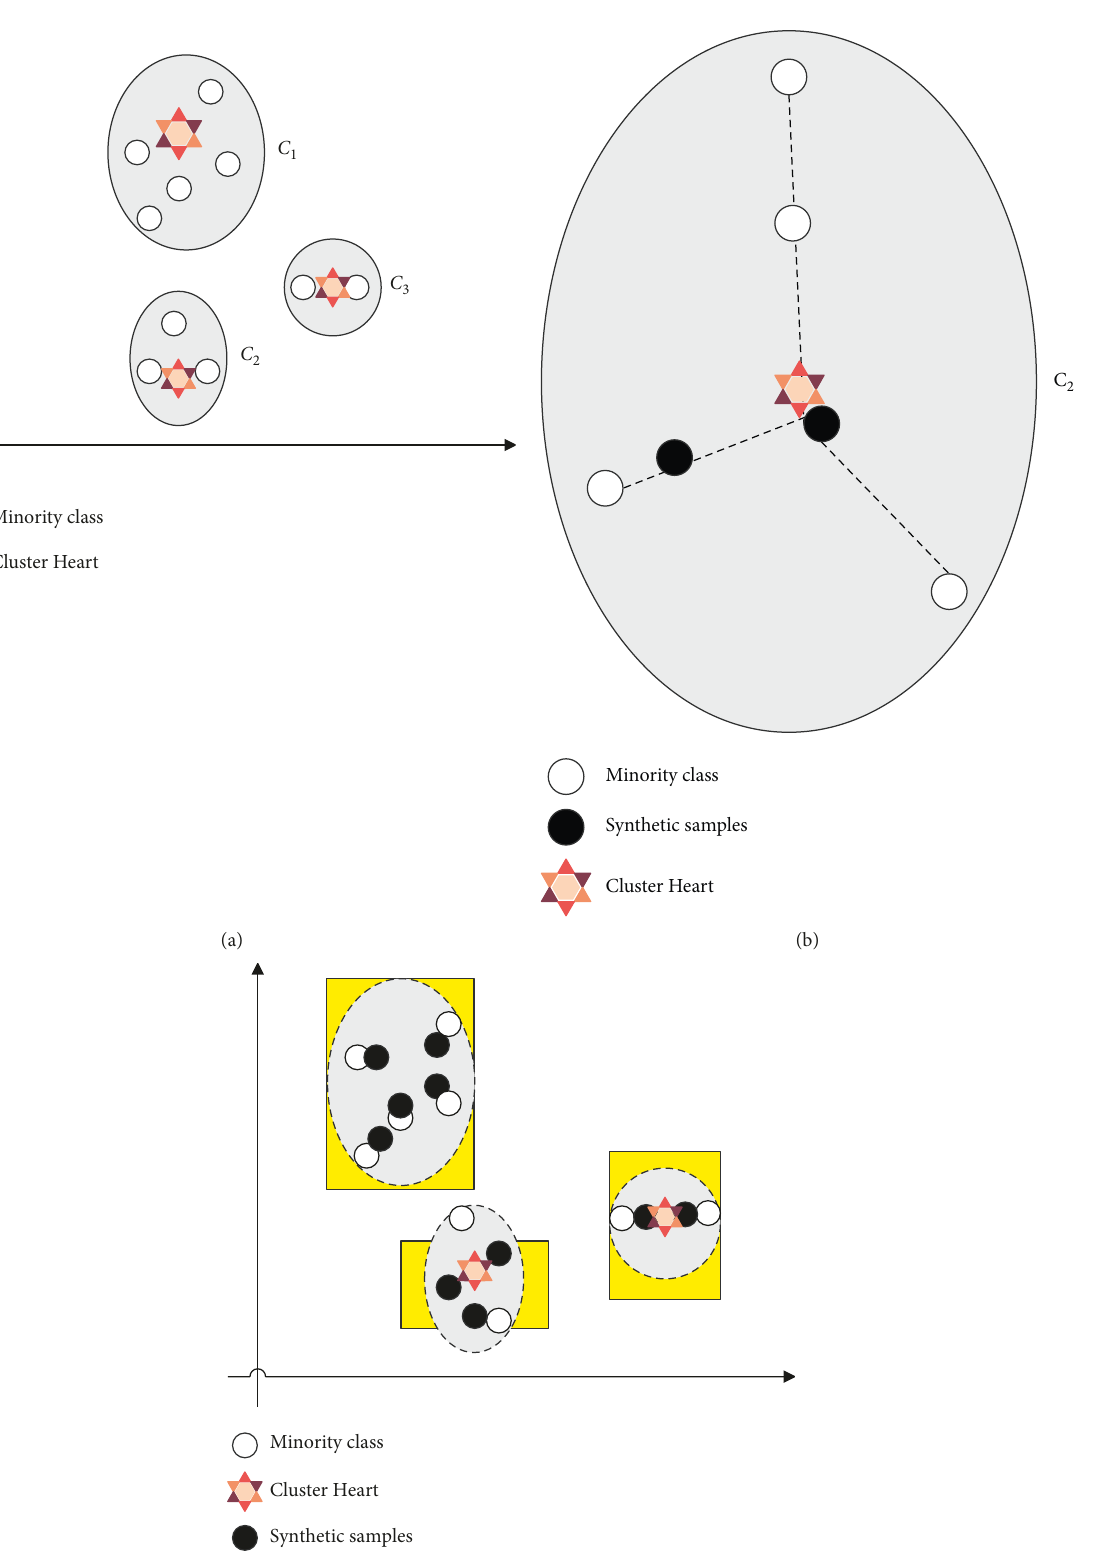
Figure 1: Processing process of data clustering. (a) Preprocessing for a minority class (b) Oversampling of cluster c the KM-SMOTE